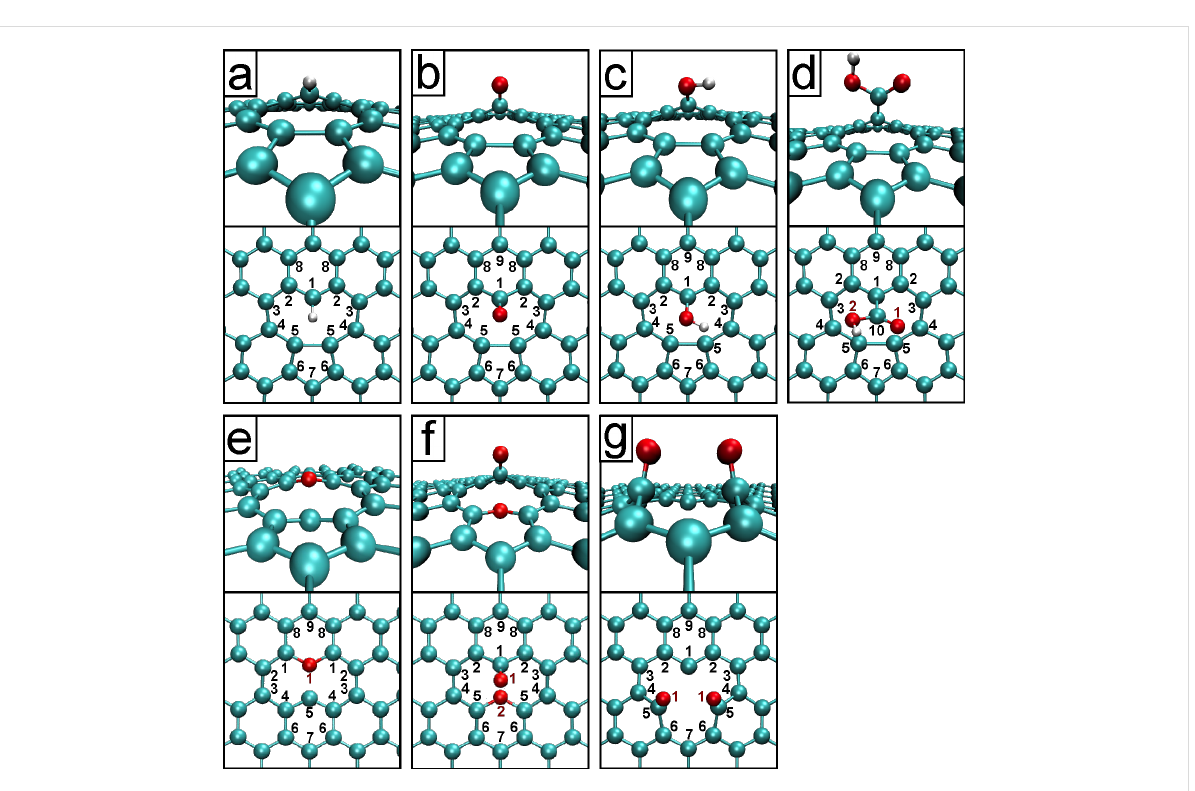
Figure 3: Cropped relaxed saturated single vacancy structures. The single vacancy saturated by a) hydrogen (SV–H), b) oxygen (SV–O), c) hydroxide (SV–OH), d) carboxyl (SV–COOH), e) annulene (SV–O–), f) ketone + annulene (SV=O+–O–), and g) diketone (SV=2O)